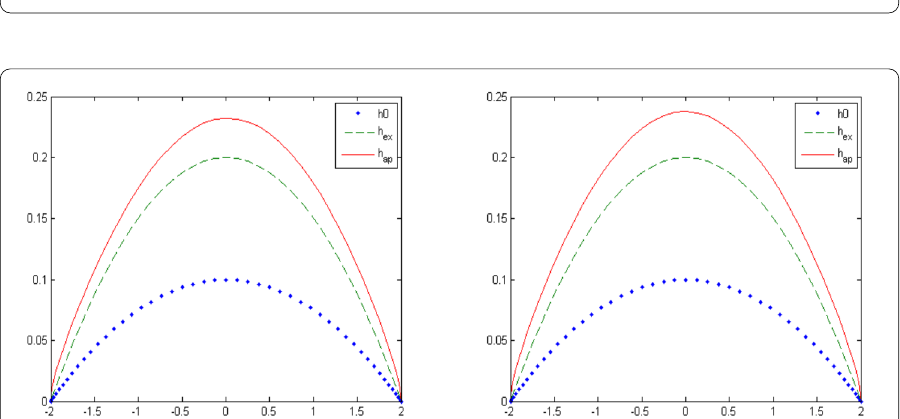
Figure 6 Reconstruction of h 1 after one iteration for exact data (left), and noisy data with δ = 0.05